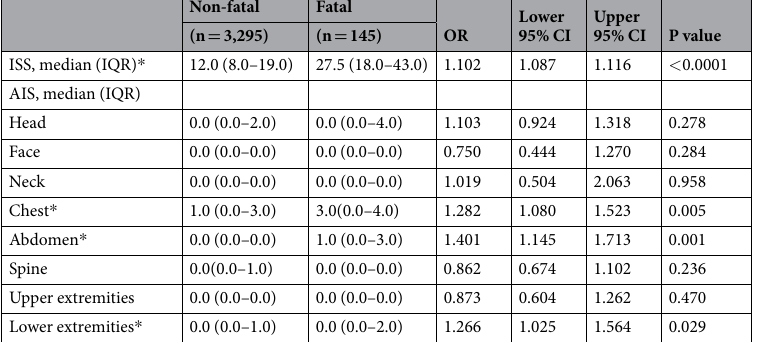
Table 6. Injury Severity Score (ISS) and Abbreviated Injury Scale (AIS) by body region of patients who survived (non-fatal group) versus patients who died (fatal group) during Period B (2016–2017). OR: odds ratio, 95% CI: 95% confidence interval. * Median values were significantly higher in the fatal group than the non-fatal group.